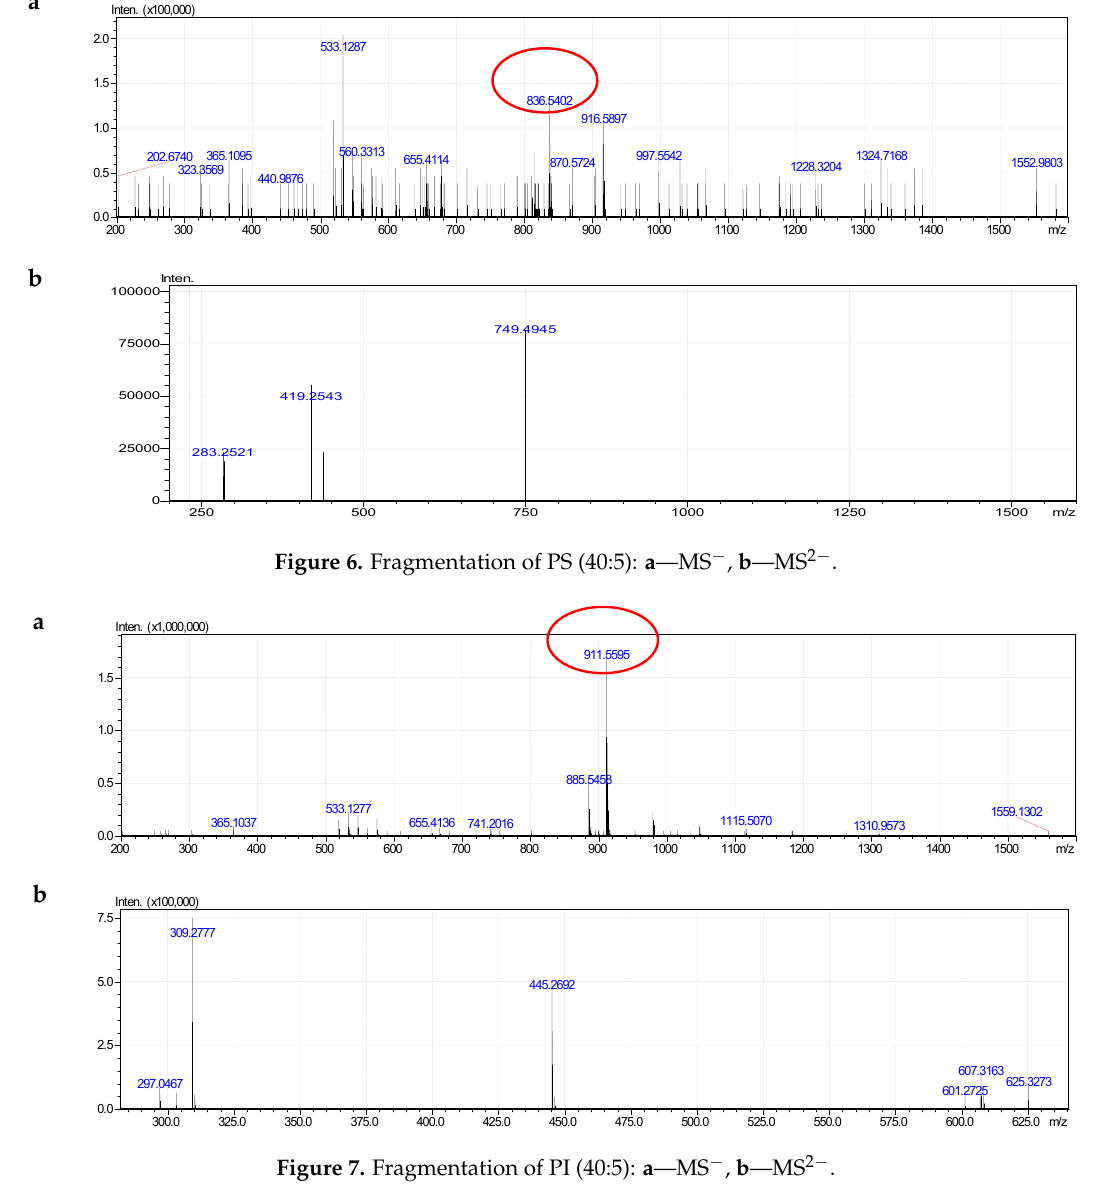
Figure 7. Fragmentation of PI (40:5): a —MS − , b —MS 2 − .